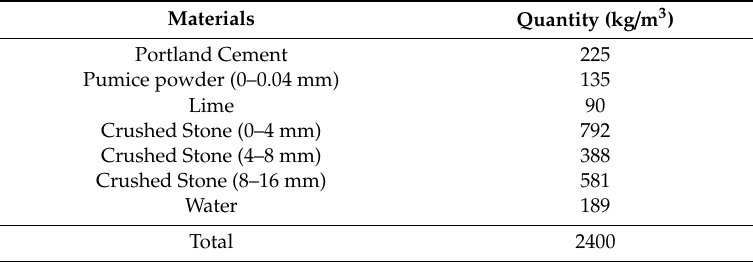
Table 17. Amounts of concrete material at optimum binder ratio.